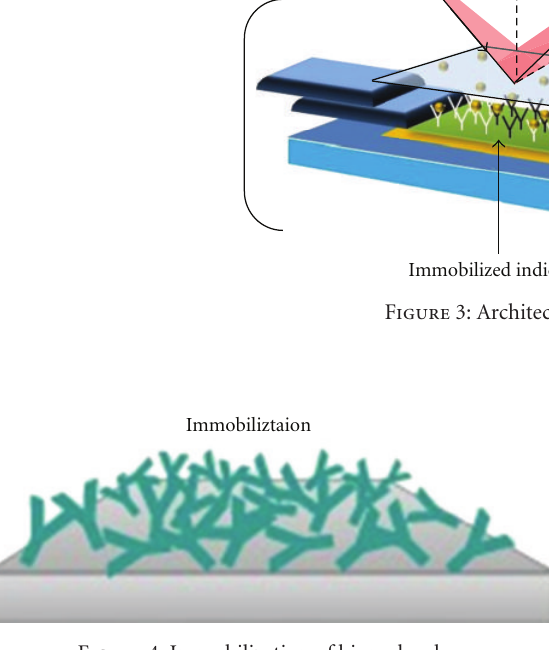
Figure 4: Immobilization of